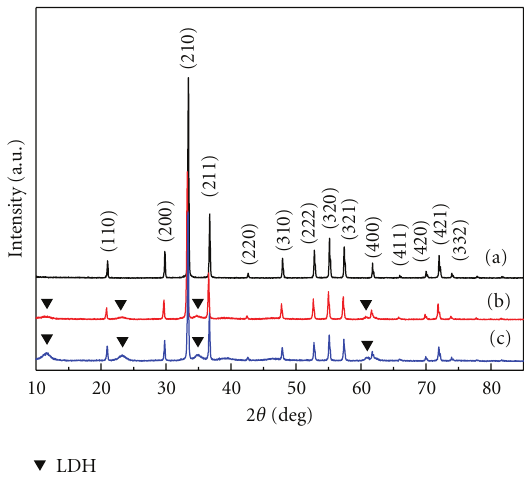
Figure 2: XRD patterns of (a) bare Ag 3 PO 4 , (b) Ag 3 PO 4 /FLDH-1.6, and (c) Ag 3 PO 4 /FLDH-3.